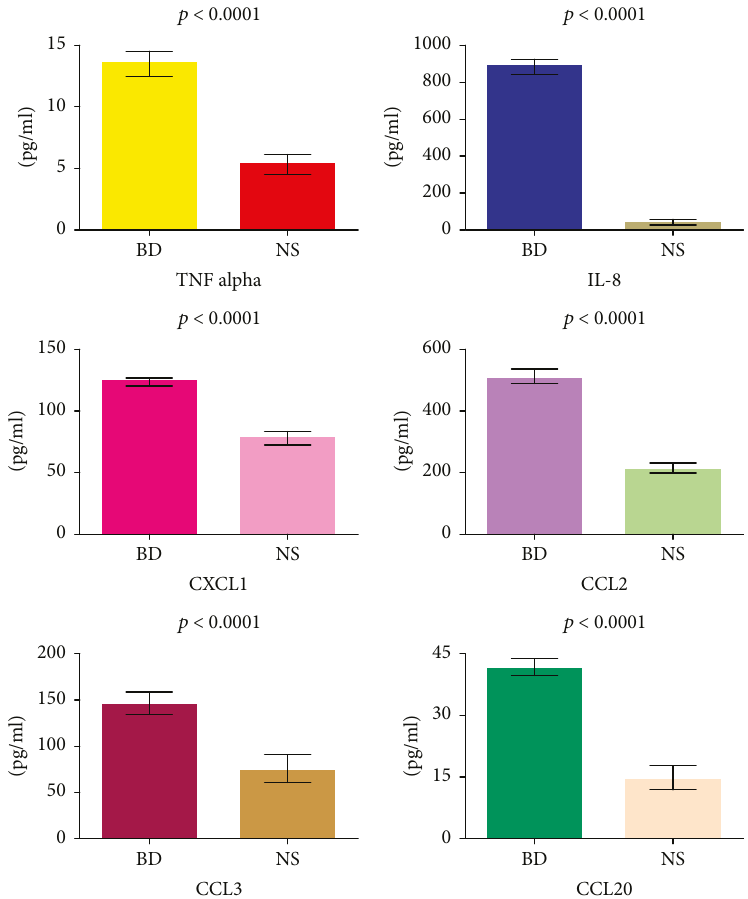
Figure 6: Serum levels of selected soluble mediators in BD patients and in normal subjects. The histograms represent the mean of the results obtained in 30 normal subjects (NS) and in 51 BD patients. p values were calculated using the Student ’ s unpaired t